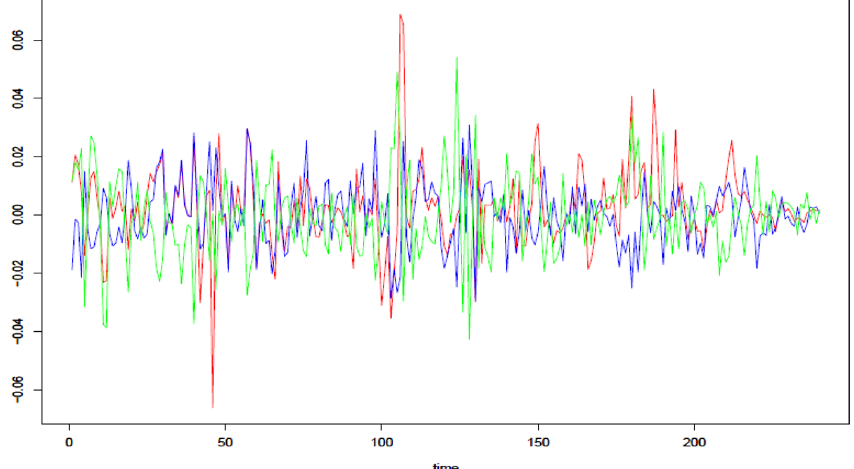
Fig. 2 Log first difference of the dinar DZD (red line), dollar USD (blue line) and EURO (green line) against the special drawing rights (Source: Own work using data from